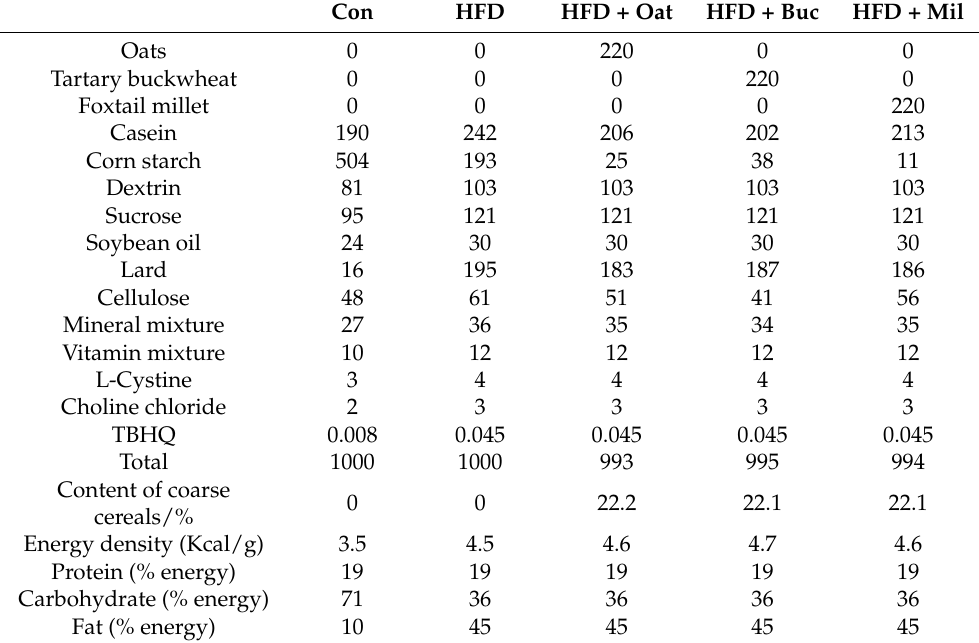
Table 1. Composition and energy density of the